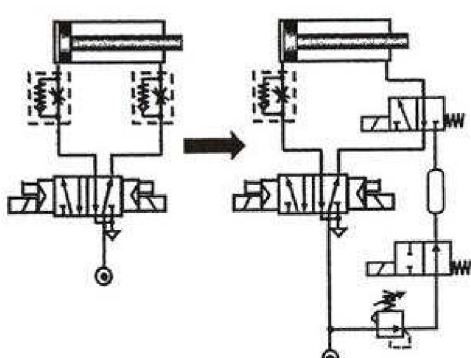
Fig. 3. Utilization of accumulated exhaust air to return stroke of cylinder [6]